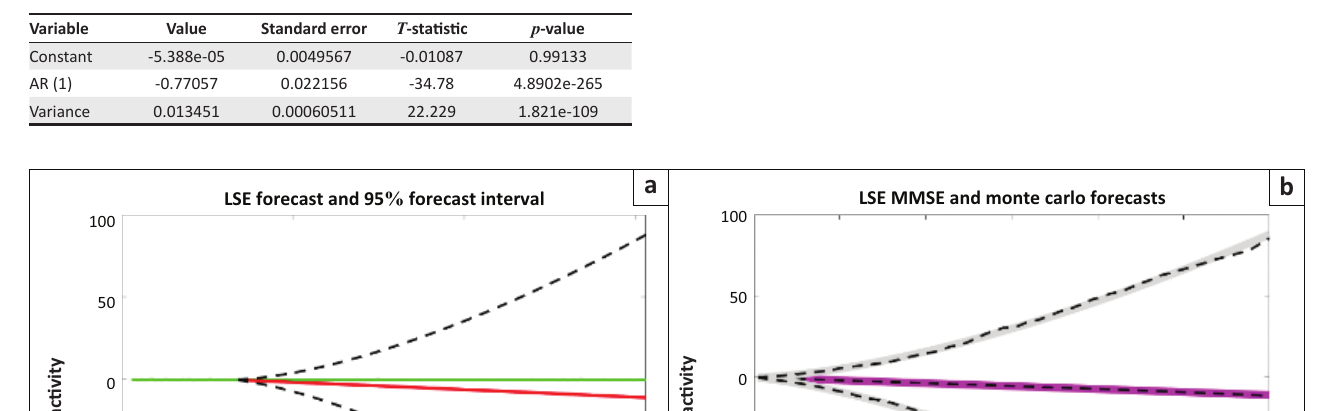
5. Modelling London Stock Exchange estimating autoregressive integrated moving average and generalised autoregressive conditional heteroscedasticity for the best possible fit of the respective